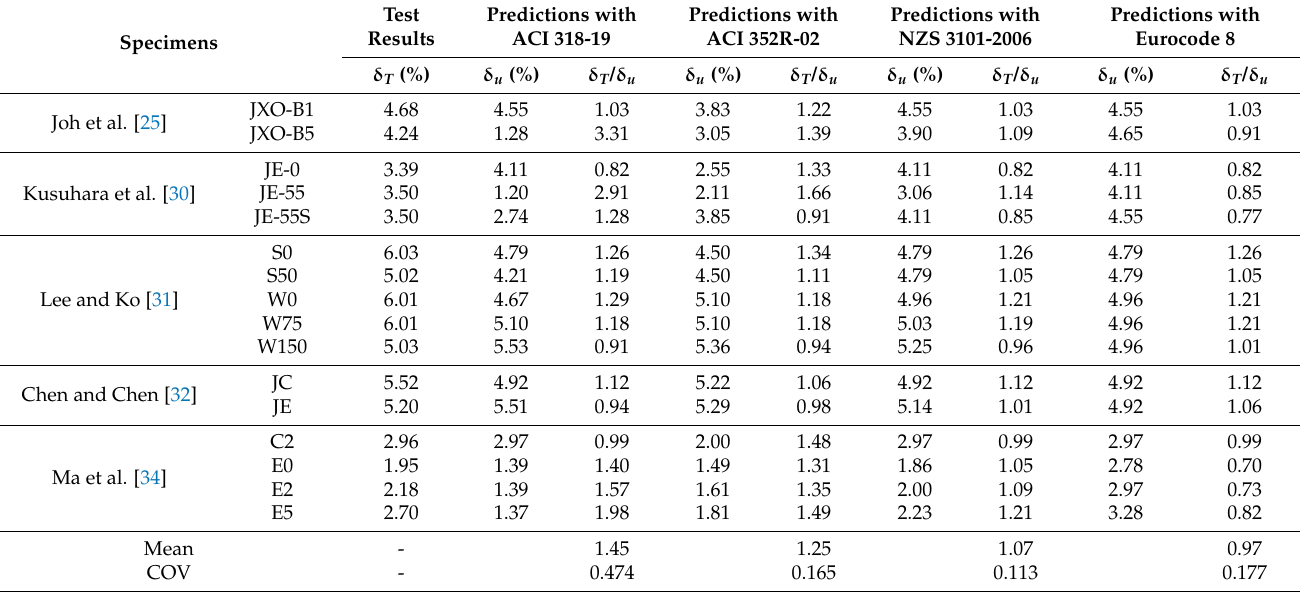
compared with the test results δ T in Table 4: the deformation capacity δ T of the test speci- mens was defined as the drift ratio corresponding to the nominal strength P y (Equations (5) model using the effective joint width of NZS 3101-2006 [14] or Eurocode 8 [15] matched well with the test results: the mean and COV (coefficient of variation) of δ T / δ u were 1.07 and 0.113 for the predictions with NZS 3101-2006, respectively, [14] or 0.97 and 0.177 for the predictions with Eurocode 8, respectively [15]. The underestimation of the predictions with ACI 318-19 [12] (1.45 and 0.474) or ACI 352R-02 [13] (1.25 and 0.165) was due to the underestimated effective joint width (Table 3): the effective joint width of the eccentric eccentricity ( x ) in ACI 318-19 [12] (Equation (1)), and the effect of beam eccentricity was indirectly considered in ACI 352R-02 [13] by using a factor m (Equation (2)). On the other hand, NZS 3101-2006 [14] directly considered the beam eccentricity ( e ) in the calculation (Equation (3)), and the calculated effective joint width of NZS 3101-2006 [14] was larger than that of ACI 318-19 [12] or ACI 352R-02 [13] but less than that of Eurocode 2 [15] without consideration of the beam eccentricity (Table 3). For these reasons, the simplified predictions for all test specimens. Table 4. Comparison of deformation capacity between test results and